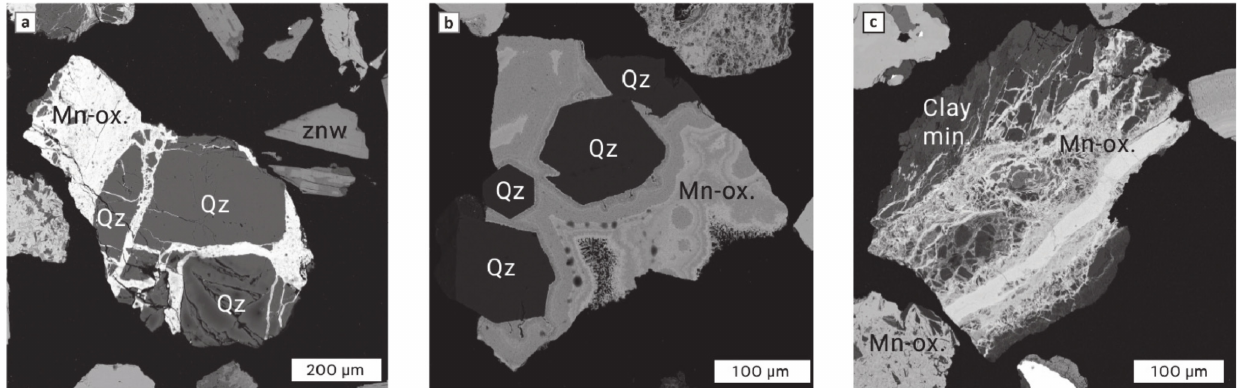
Figure 9. ( a ) SEM/EDS-BSE image of Mn-rich phase filling cracks in quartz grain, ( b ) quartz crystals cemented by botryoidal zoned manganese oxide overgrowth and ( c ) weathering products of the feldspars (kaolinite) and the iron-manganese phases. Explanation: Qz = quartz, Mn-ox = Mn-rich oxides, Clay min. = clay